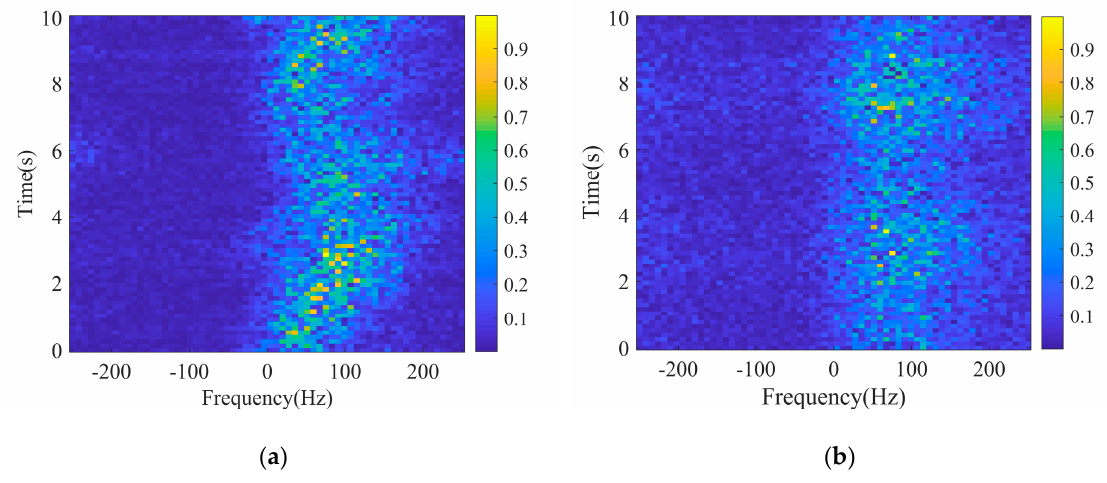
Figure 15. Doppler spectra of real and generated clutter (range bin = 300): ( a ) Original; ( b ) STCPM.